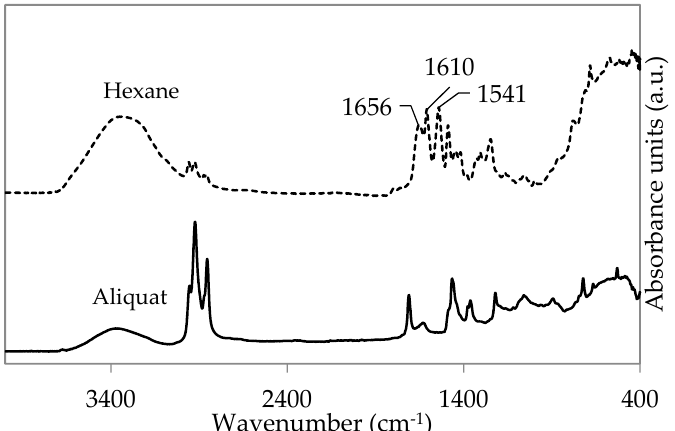
Figure 8. Attenuated total reflectance Fourier transform infrared (ATR-FTIR) spectra of PA film prepared using 1.5 wt% TMC in both hexane (dotted line) and Aliquat (full line).